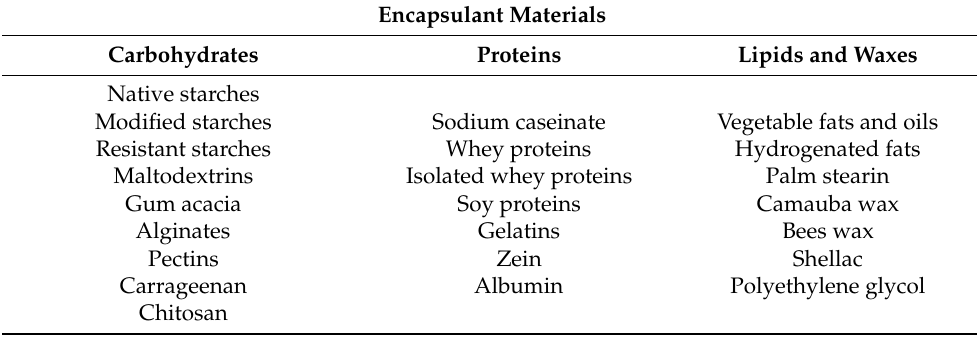
Table 2. Common materials used to encapsulate omega-3 PUFAs in food applications.